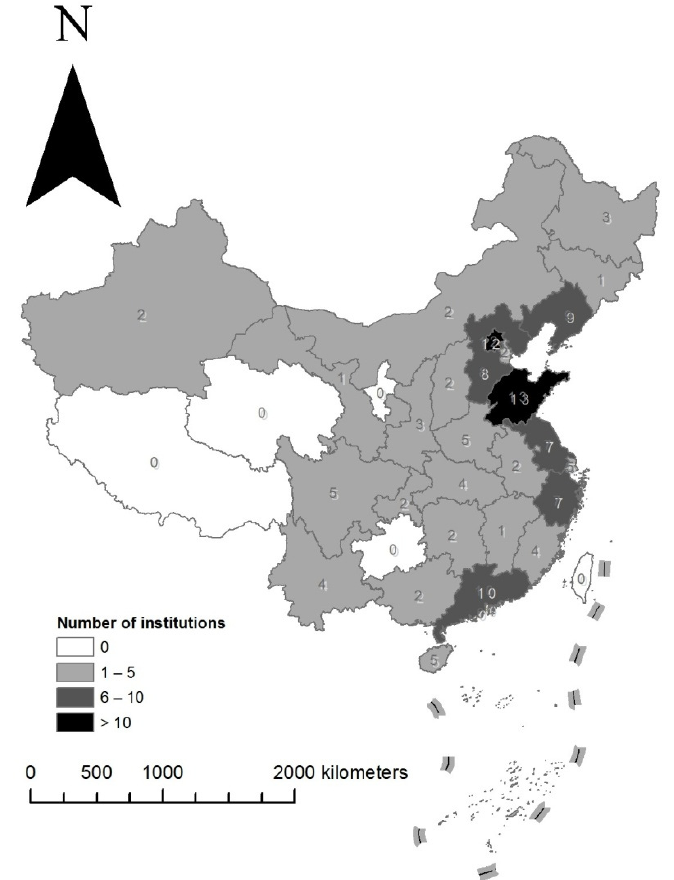
Figure 1. Provincial level distribution of duty-free import institutions in China in this study, accord- ing to the Endangered Species Import and Export Management Office of the Peoples Republic of China (CFGA-CITES) between 1996 and 2015 ( n = 123, the numbers in the figure are the number of institutions in each province).